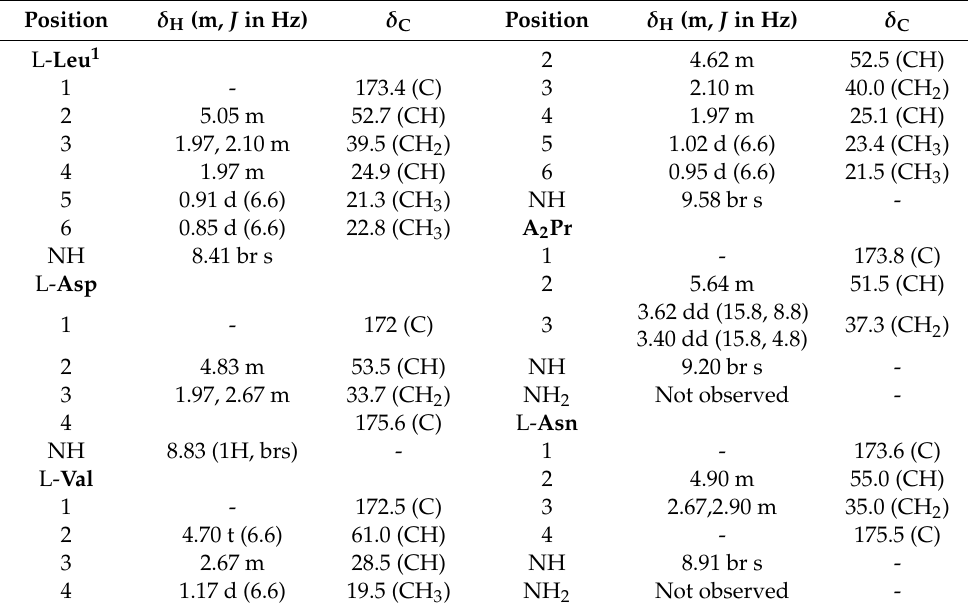
Table 1. 1 H and 13 C NMR data of compound 1 (pyridine- d 5 ) a